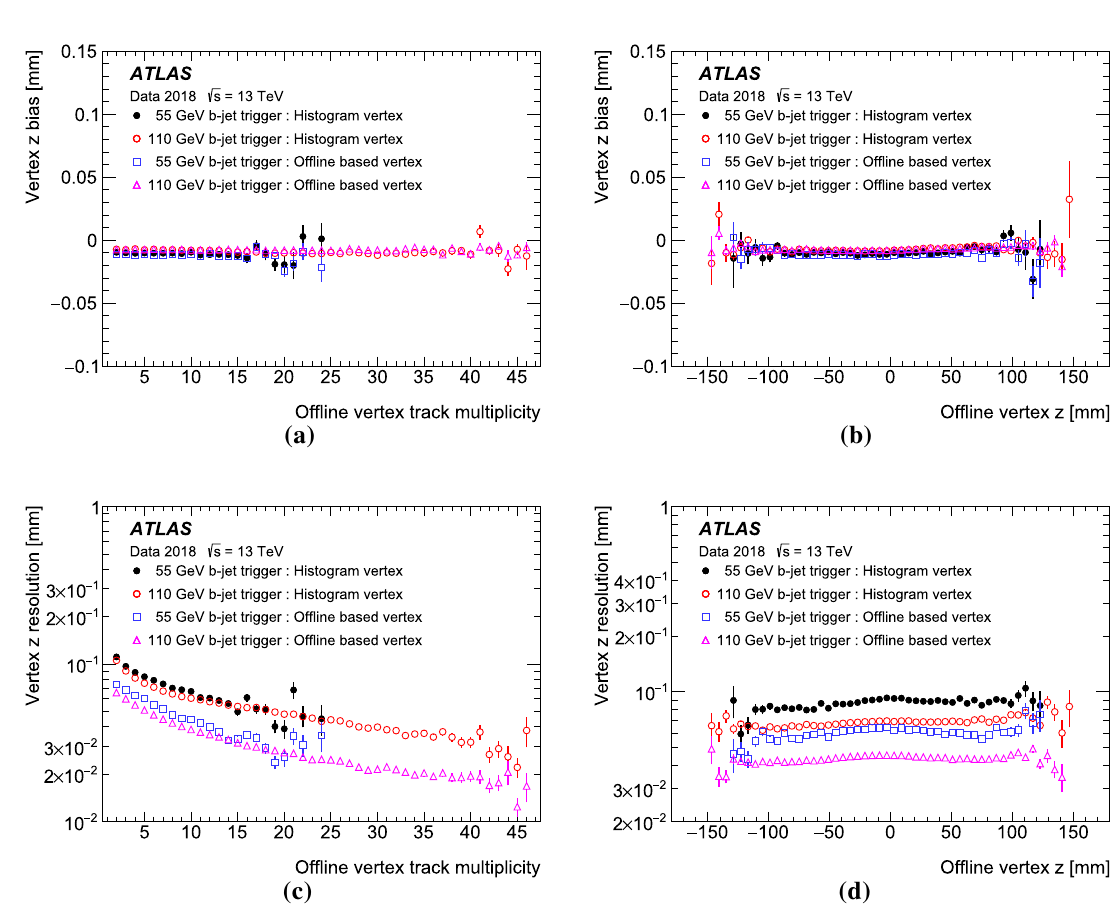
offline tracks within the super RoI which are matched to the vertex, and the b bias, and d resolution, with respect to the offline vertex z